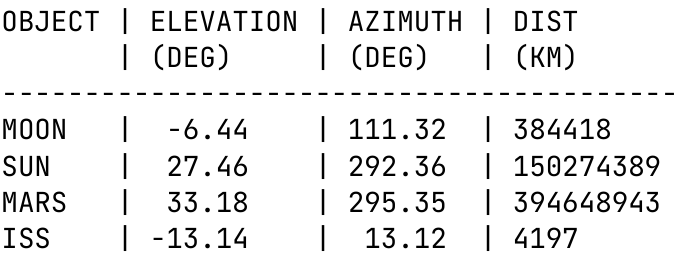
Figure 5. Moon, Sun, Mars, and ISS local elevations, azimuths, and distances. The elevations for the Sun and Mars are positive, meaning they were visible from the horizon at the time of measuring, while the ISS and moon were below the horizon. (DEG =